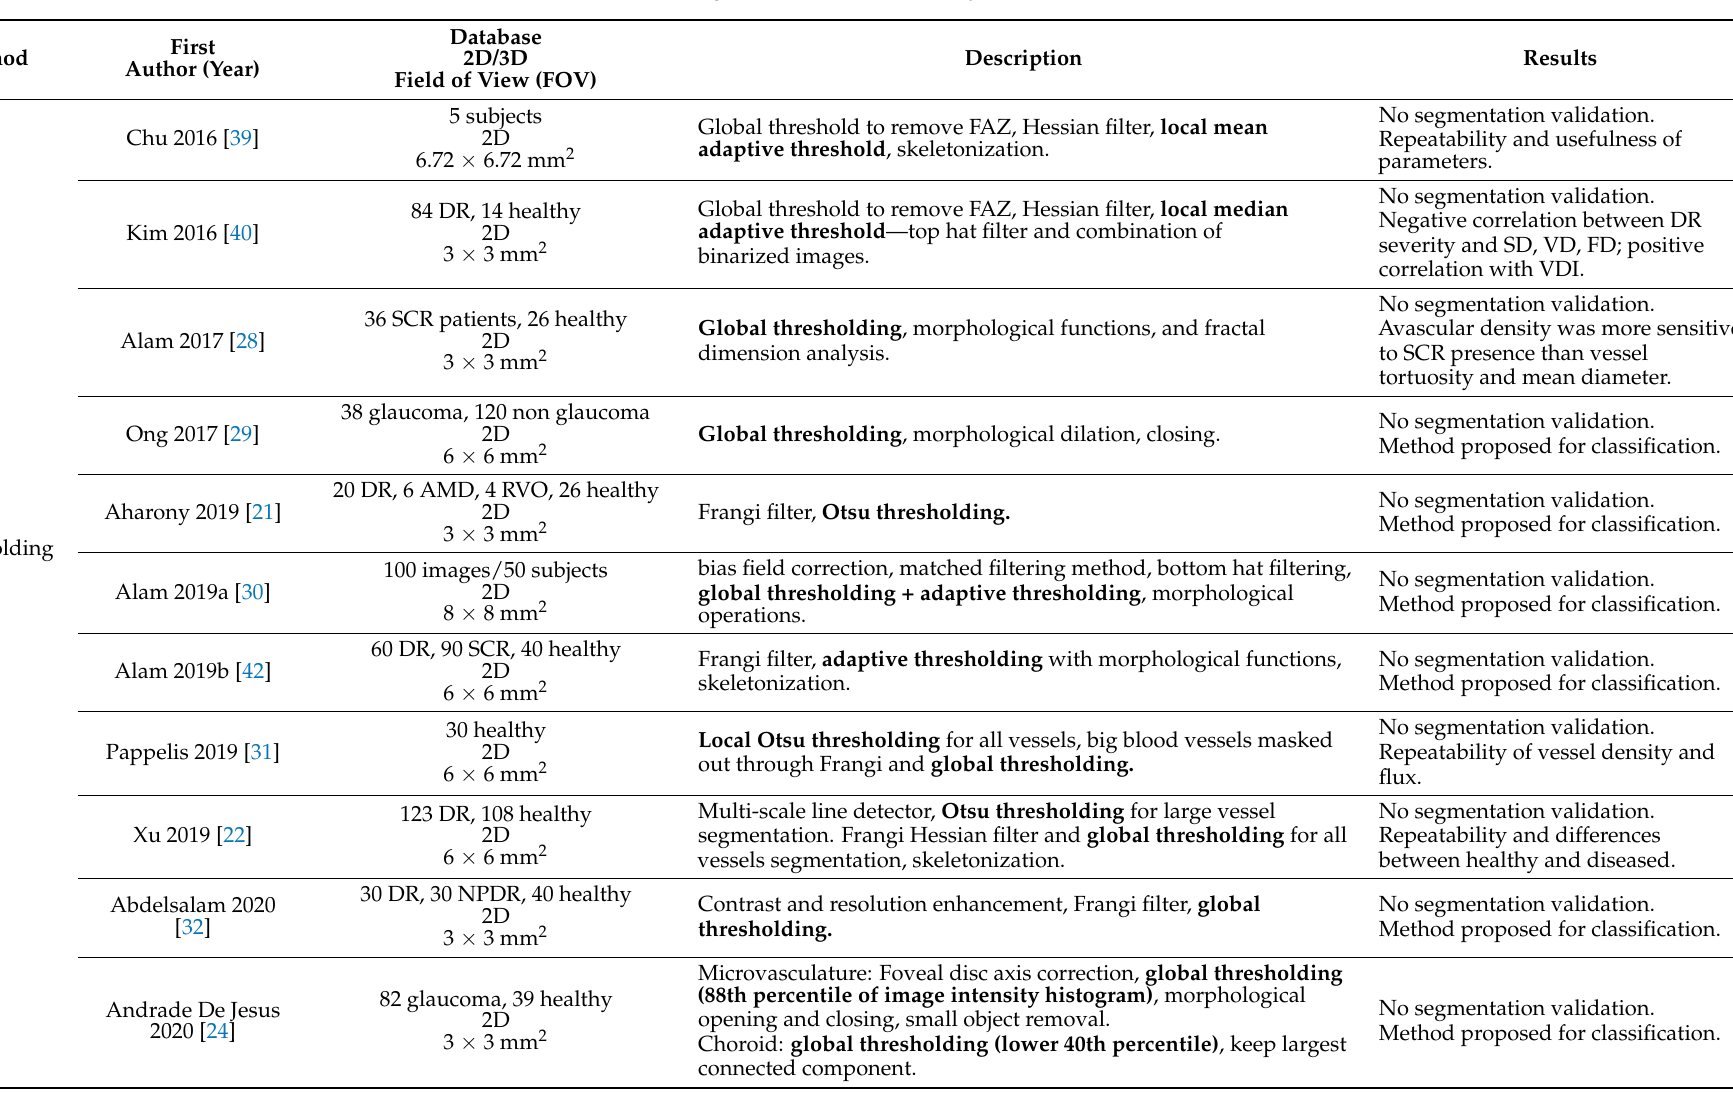
Table 1. Segmentation tasks